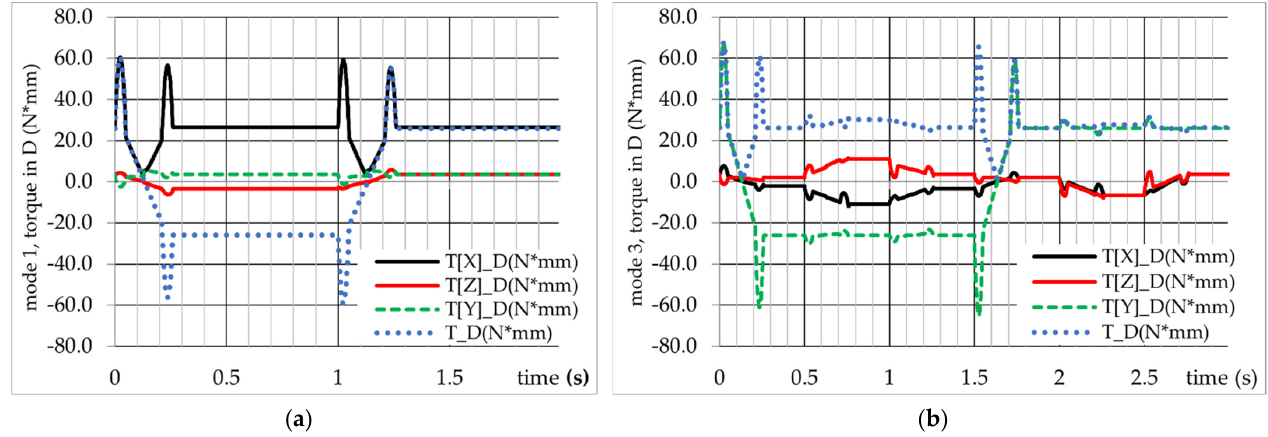
Figure 7. Computed results in terms of torques of D of the first leg: (a) in Mode 1; (b) in Mode 3.